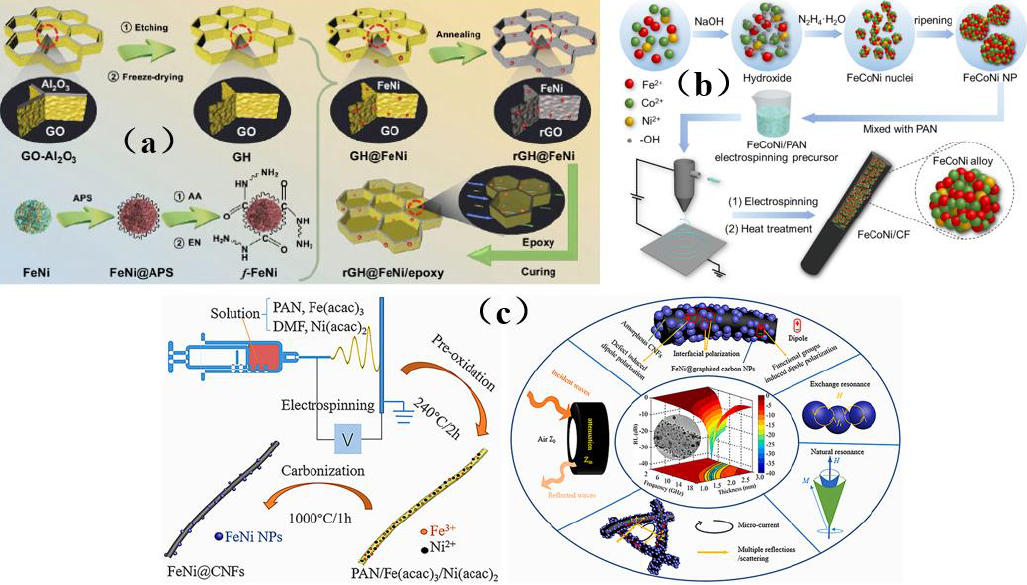
Figure 21. ( a ) Schematic diagram showing the preparation of an RGH@FeNi/epoxy composite [152]. Copyright 2022, SpringerOpen. ( b ) Schematic diagram of the synthesis strategy leading toFeCoNi/CF composites [153]. Copyright 2022, SpringerOpen. ( c ) Schematic diagram and mechanism diagram of the manufacturing process leading to FeNi@CNFs [154]. Copyright 2022, Elsevier.